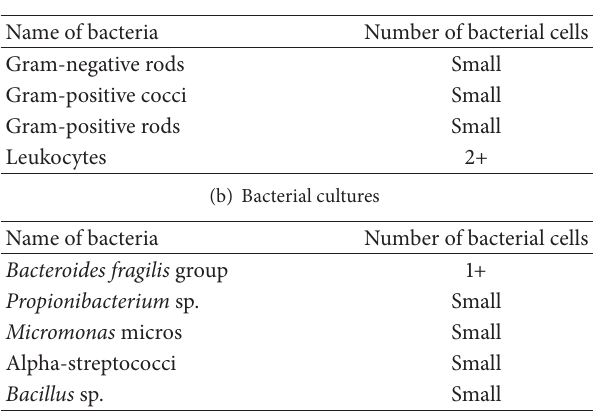
Table 2: Bacteriological examination of ascitic